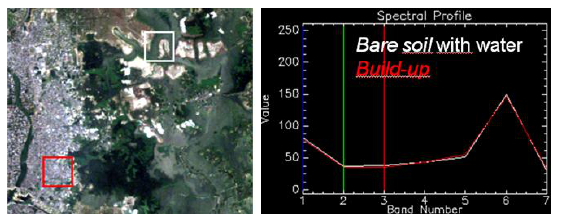
Figure 7. Spectral profile comparison between filling material in contact with water and urban areas